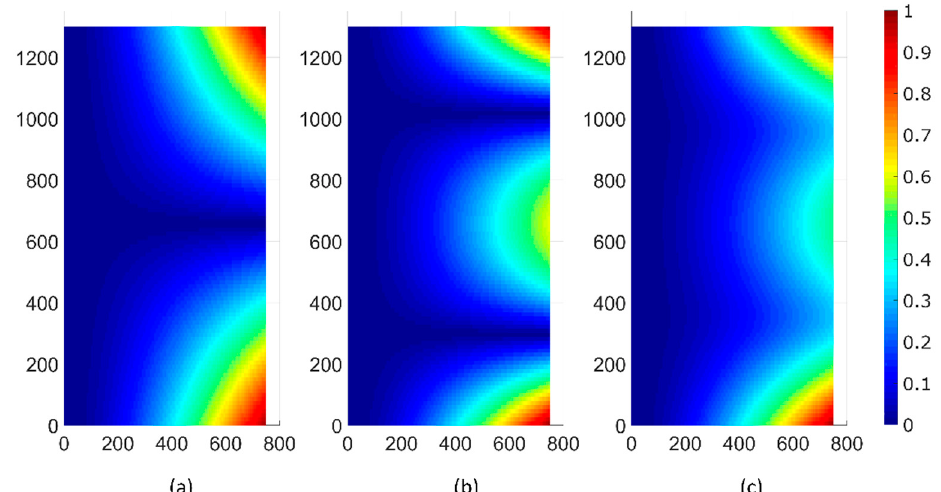
Figure 3. Envelope of the maximum displacement over the cantilever surface of ( a ) Mode (11), ( b ) Mode (12), and ( c ) Equation (1) with the parameters mentioned in the text. The color scale represents the unitary displacement.